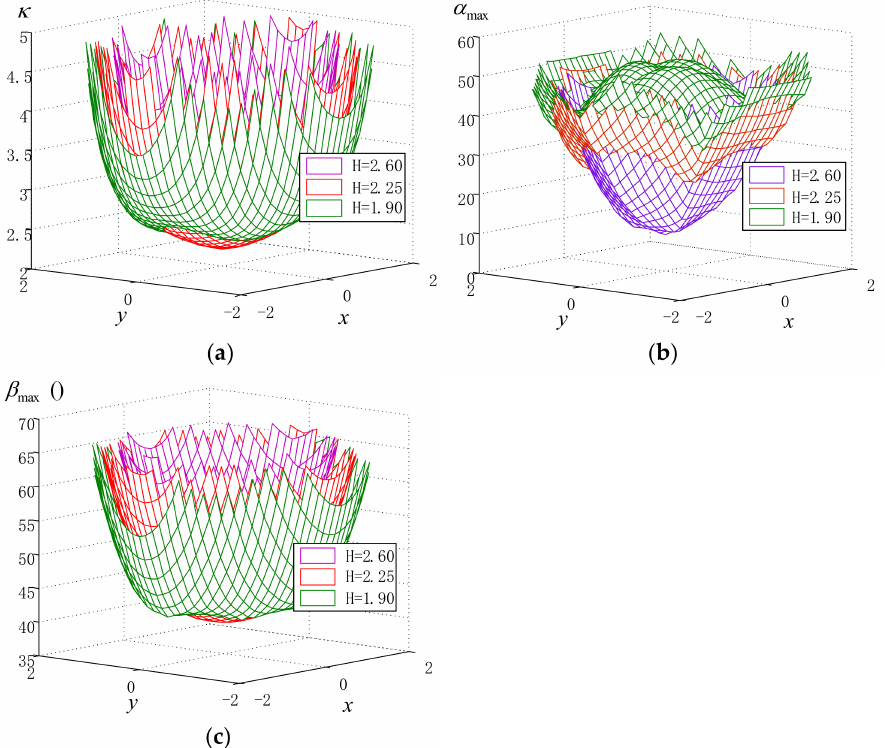
Figure 7. Contours of κ and of the maximum ITA and CTA in bounded workspace. Variations in ( a ) κ , ( b ) ITA— α max = max ( α 1 α 2 α 3 ) and ( c ) CTA— β max = max ( β 12 β 23 β 31 ) versus changes in H = 1.9 ∼ 2.6 in workspace bounded by κ 0 =